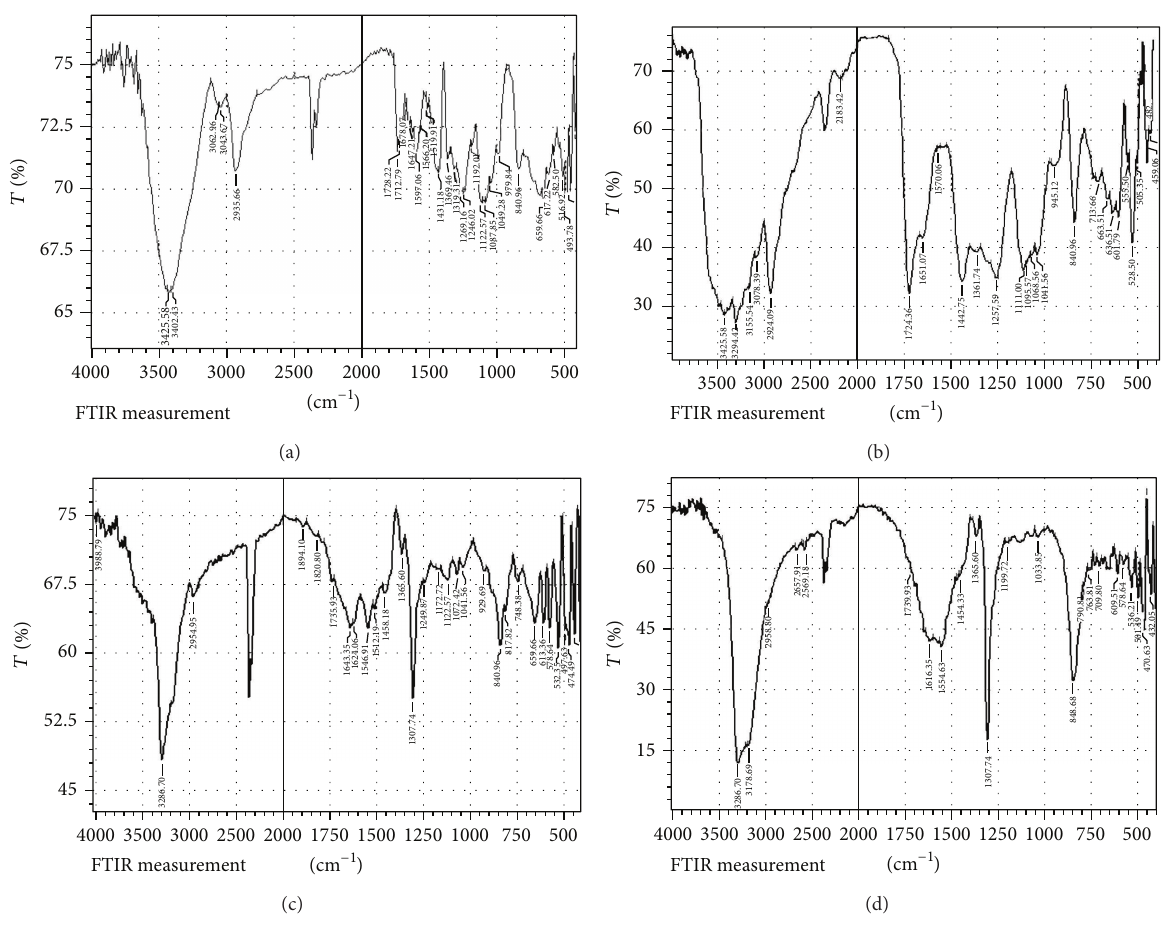
Figure 4: FTIR graph of PVAc/[Co(NH 3 ) 5 Cl]Cl 2 composites film with different concentrations: (a) pure PVAc, (b) 3 wt.% (c) 6 wt.%, and (d)